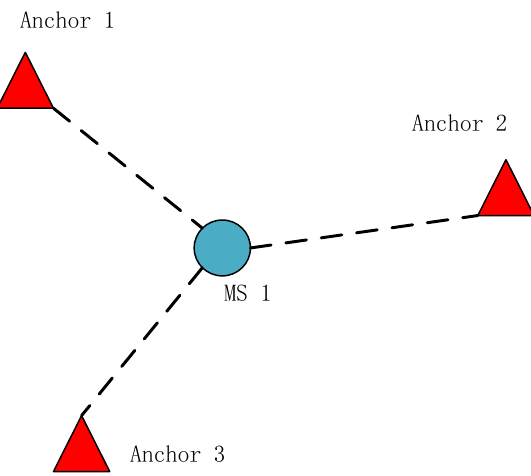
Figure 1. Demonstration of the typical source localization system.